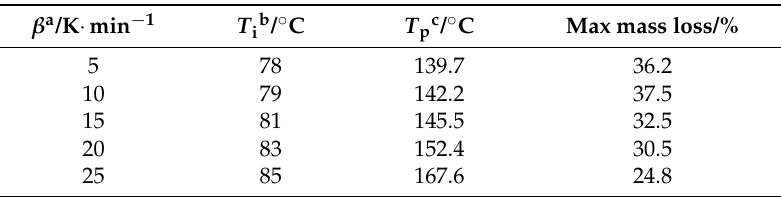
Table 2. Basis kinetic data of the blocked isocyanate.